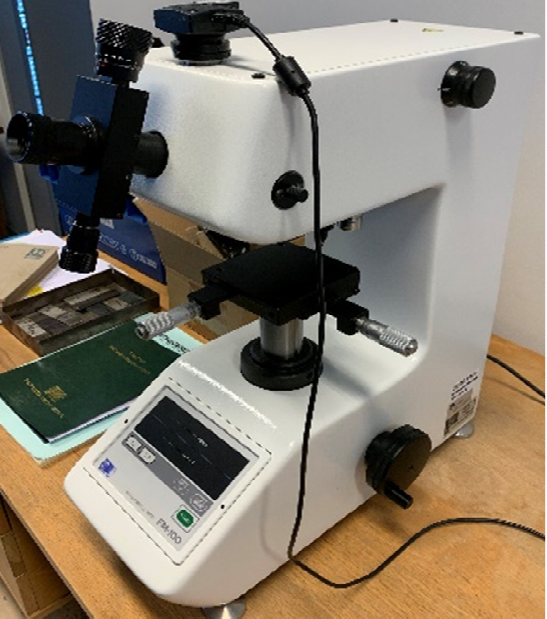
Figure 3. Microhardness tester Future-Tech FM 100.